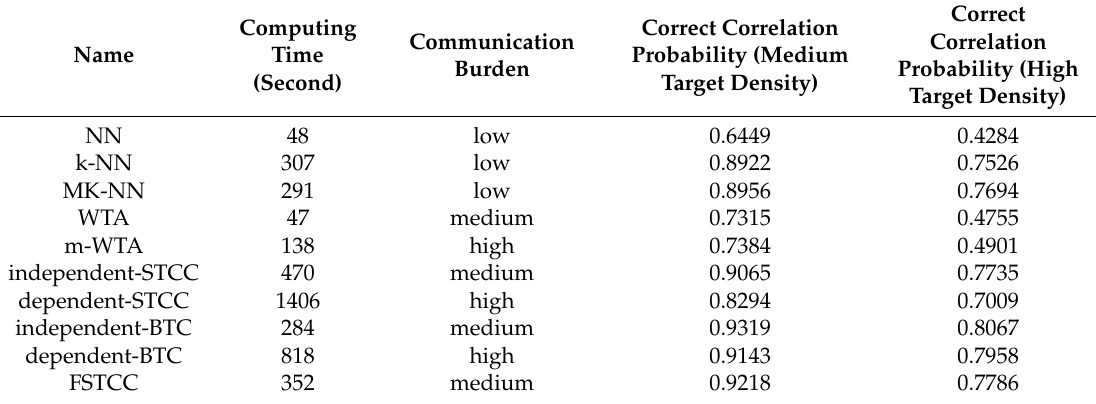
Table 1. Performance comparison of track correlation algorithm for distributed multisensor